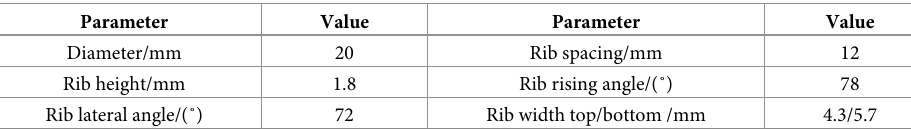
Table 2. Profile configurations of right spiral